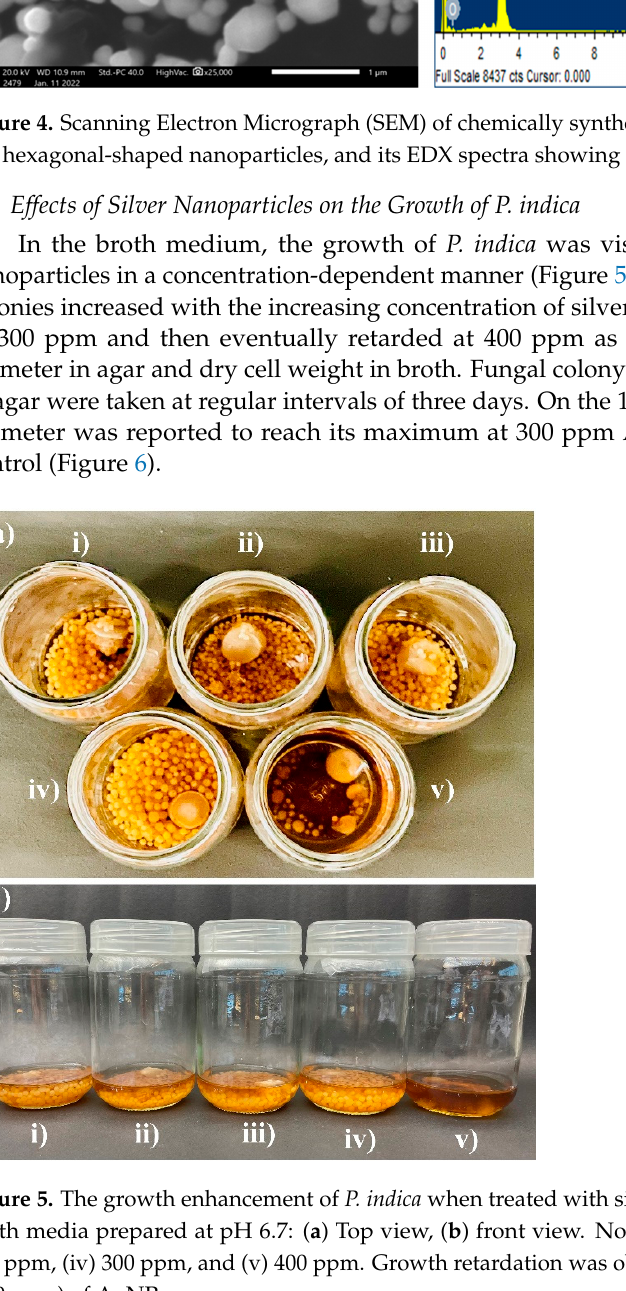
Figure 6. Growth enhancement of silver nanoparticle treated P. indica on agar media showing com- parative growth enhancement with AgNPs untreated control (i) and treated P. indica (ii). The increase in (a) fungal colony diameter with an increase in AgNPs concentration in agar and (b) dry cell weight with an increase in AgNPs concentration in broth is seen Figure 7. In comparison to the control (3.6 cm fungal colony diameter) Figure 6(i), maxi- mum growth was observed at 300 ppm (8.4 cm treated colony diameter) Figure 6(ii) in